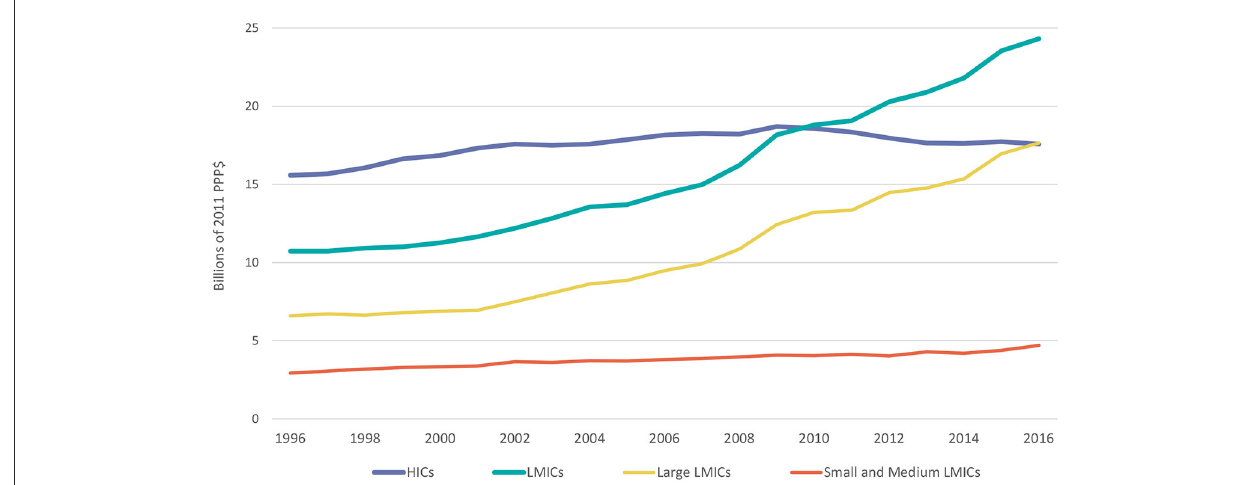
FIGURE3 Trends in public agricultural R&D investment in HICs and LMICs grouped by the size of their research system, 1996–2016. Sources: Elaborated by authors based on Agricultural Science and Technology Indicators (2022) and United States Department of Agriculture, Economic Research Service (2022). The size of the national agricultural research system is determined based on average annual agricultural R&D investment (in 2011 PPP$) for the 1996–2000 period. Large: > 400 million PPP$; Medium: 100–400 million PPP$; and Small: < 100 million PPP$.